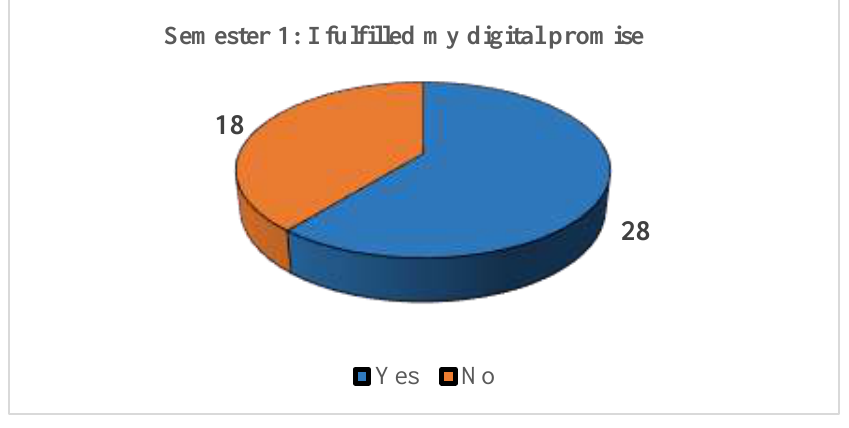
Comparison Between Fulfilled and not Fulfilled Digital Promises During Semester 1 and 2